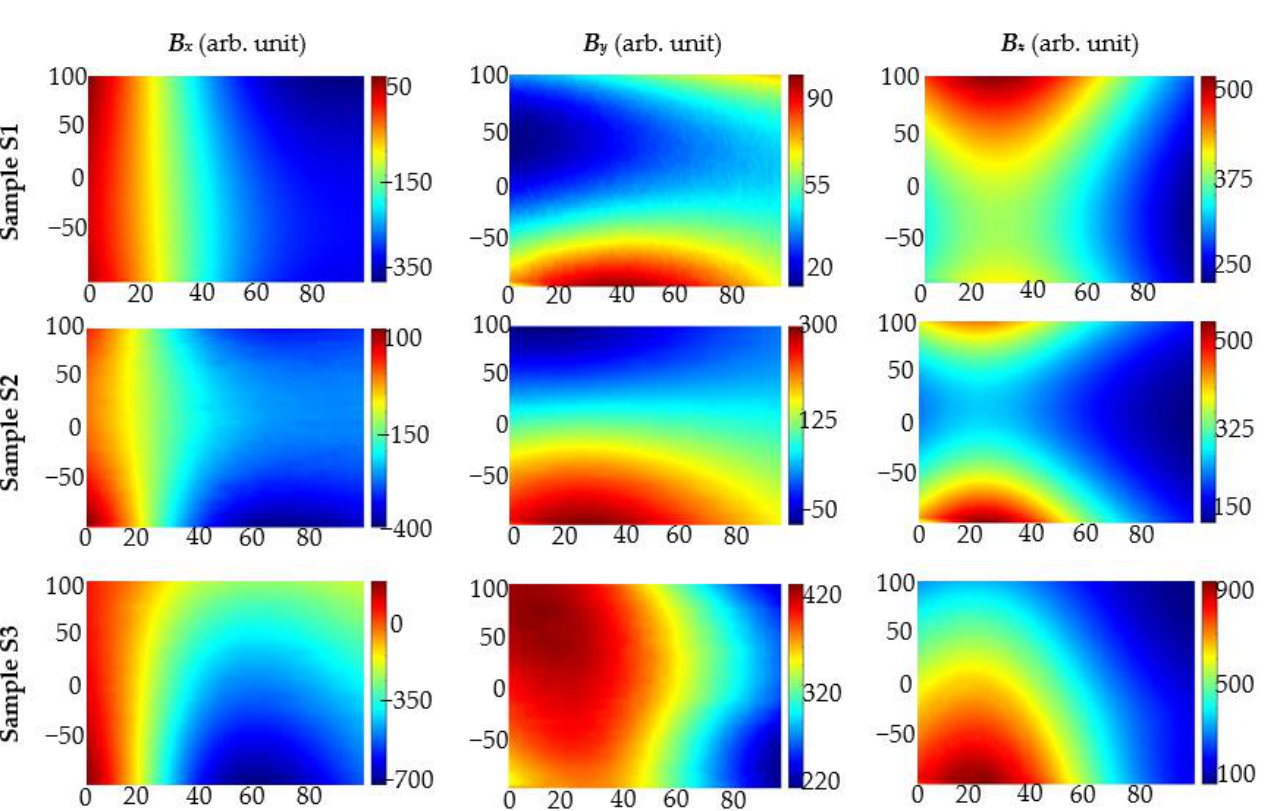
Figure 24. Results of 2D measurements using AMR sensor received for different samples (S1, S2, S3); the magnetization SPM; the thickness of the concrete cover h = 40 mm; x (mm), y (mm)—sensor positions.